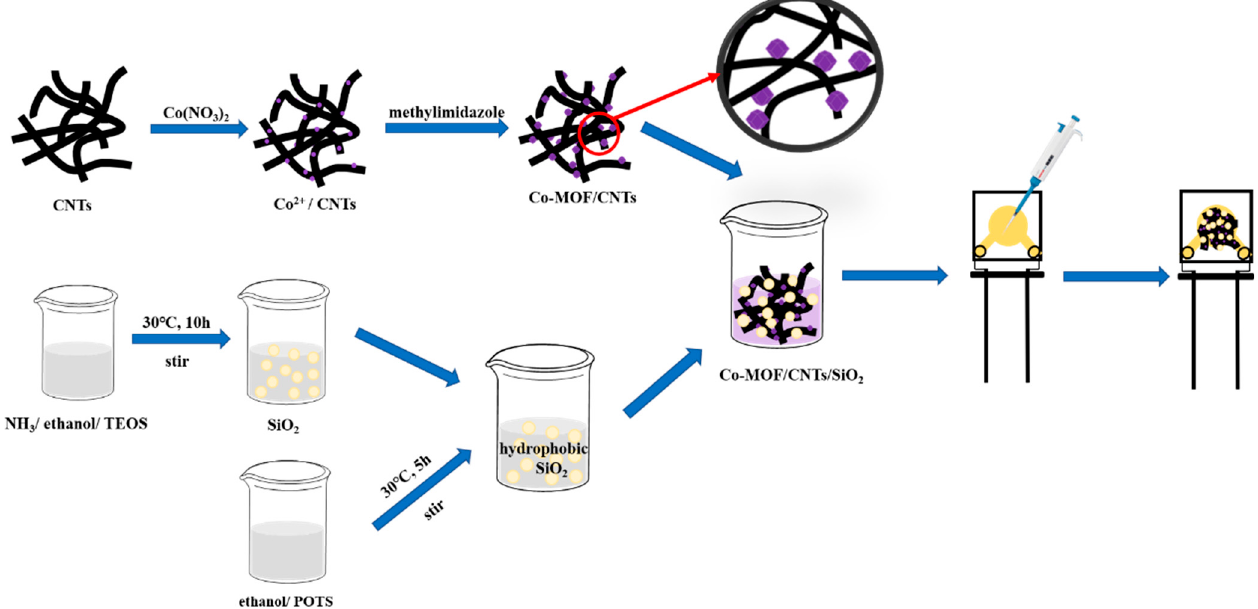
Figure 1. Schematic diagram of the fabrication of the Co-MOF/CNTs/SiO 2 /AuE.